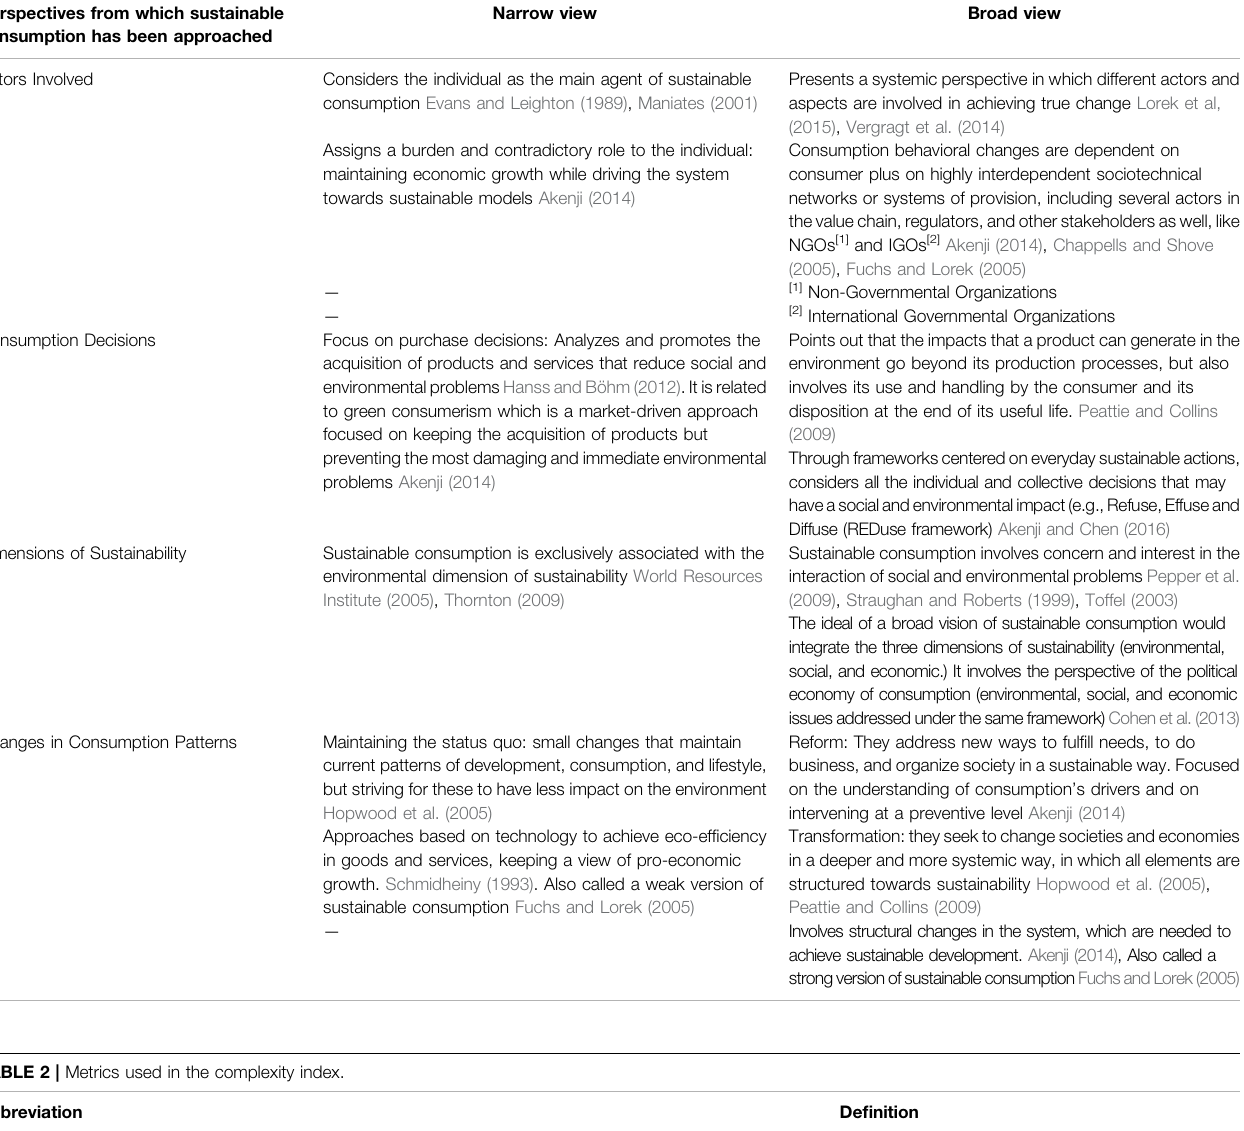
TABLE 1 | Description of the analysis perspectives and visions of sustainable consumption. Perspectives from which sustainable consumption has been approached